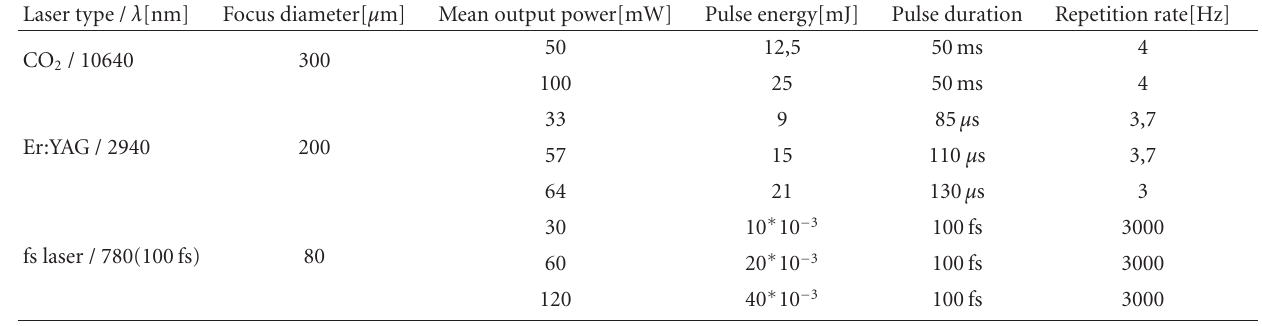
Table 1: Laser parameters used for the various laser types.